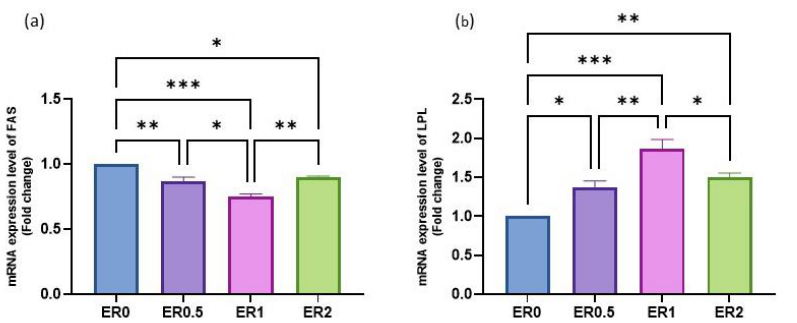
Figure 6. The relative expression profile of SOD ( a ), TNF-α ( b ), and HSP70 ( c ) genes of Red tilapia fed different dietary levels of ER. Values are expressed as mean ± SE from triplicate groups. p values of one-way ANOVA followed Tukey’s post hoc test for significant differences. p < 0.05 (*), p < 0.01 (**), and p < 0.001 (***) between different treated groups.